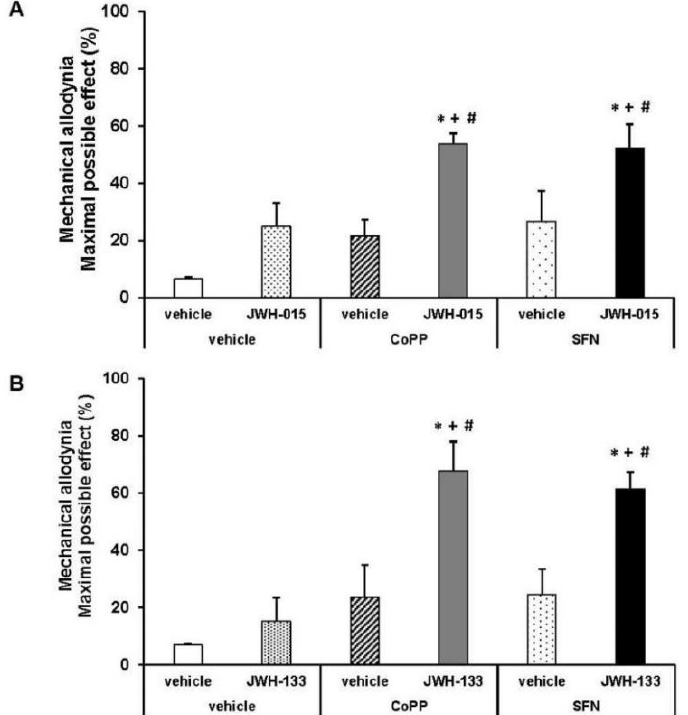
Figure 5. Effects of the co-administration of CoPP or SFN with JWH-015 or JWH-133 on the inhibition of mechanical allodynia in diabetic mice. Antiallodynic effects of the subcutaneous administration of 0.15 mg/kg of JWH-015 ( A ) or JWH-133 ( B ) or their respective vehicle in the hind paws of db/db mice pretreated with 5 mg/kg of CoPP, 10 mg/kg of SFN or vehicle are represented. The effects of CoPP and SFN intraperitoneally administered alone are also shown. For each drug tested, * denotes significant differences vs. mice treated with vehicle plus vehicle or vehicle, + denotes significant differences vs. animals treated with vehicle plus JWH-015 or JWH-133 and # denotes significant differences vs. animals treated with CoPP or SFN plus vehicle ( p < 0.05; one way ANOVA followed by the Student Newman Keuls test). Each column represents the mean value of maximal possible effect (%) and vertical bars indicate SEM; n = 6 animals for each group.